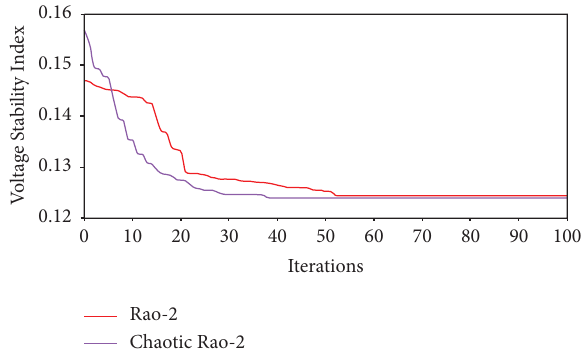
Figure 5: Convergence traits for case 3 using Rao-2 and the chaotic Rao-2 algorithms.